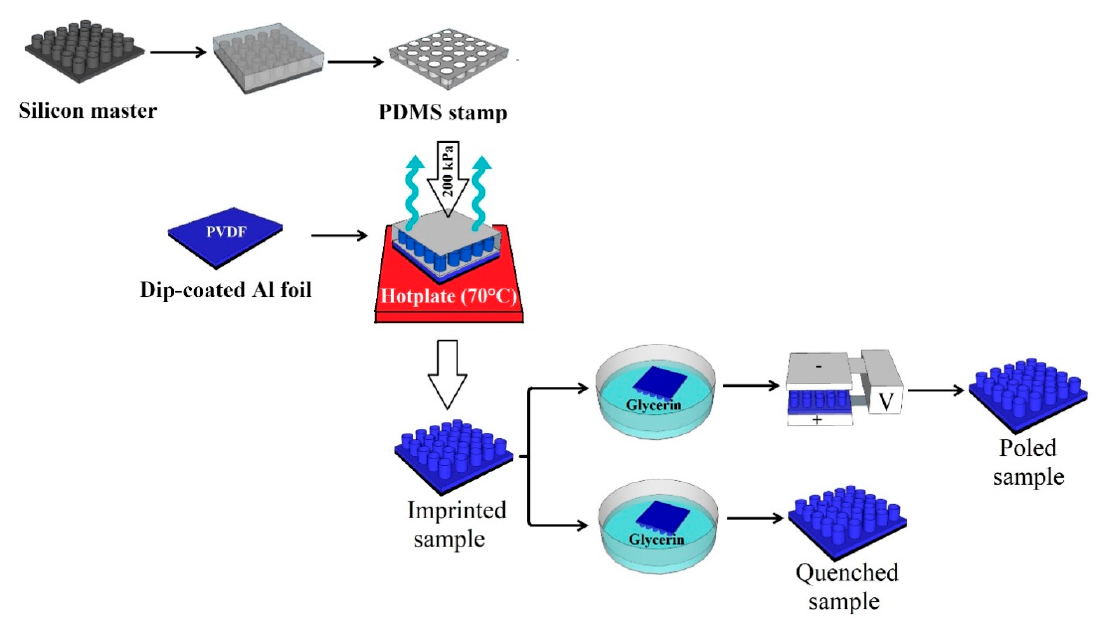
Figure 2. Schematic representation of the preparation of the polydimethylsiloxane (PDMS) soft mould and reverse micro imprint lithography.